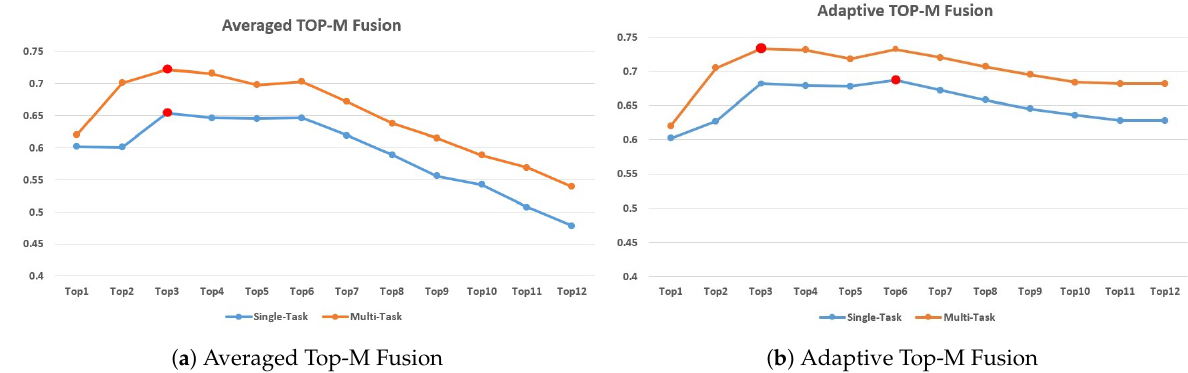
Figure 5. The CCC scores for different number of top M modalities fusion. Each color represents different tasks. The points with best results are marked as